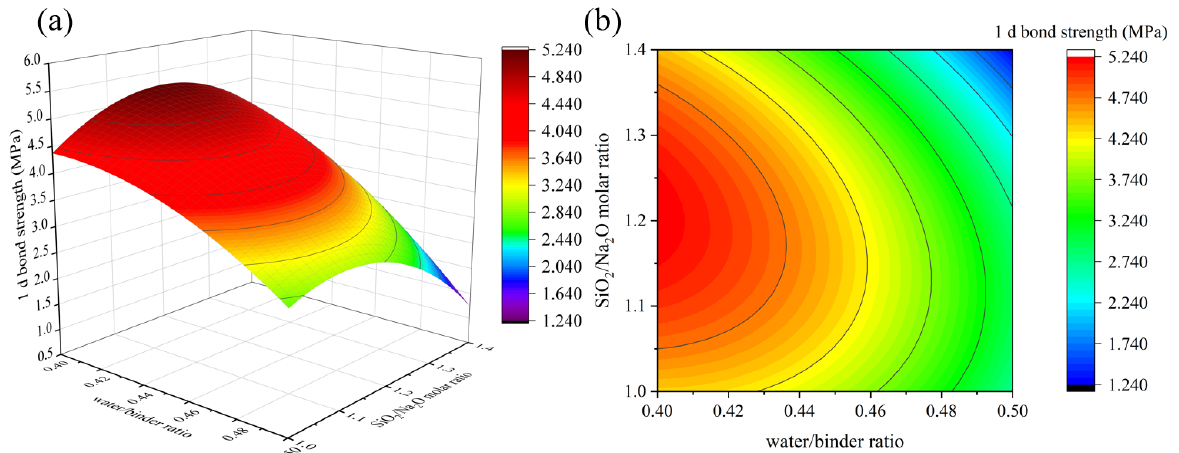
Figure 15. The interaction effect of water/binder ratio and SiO 2 /Na 2 O molar ratio on 1 d bond strength: ( a ) 3D response surface; ( b ) contour diagram.